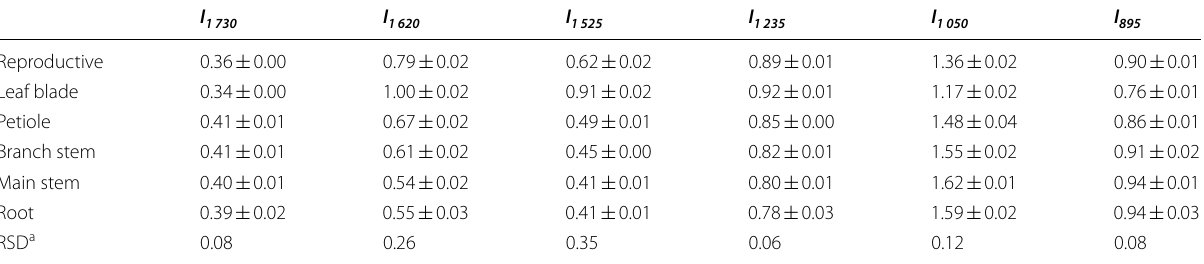
Table 1 The normalized intensities of six ATR FT-IR bands of the plant biomass from the reproductive stage. Data are presented as average standard deviation (n 4) ± =